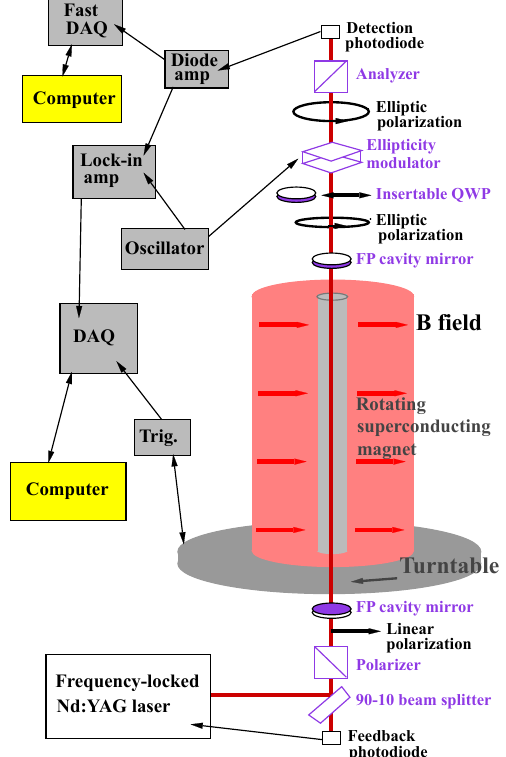
Figure 10. Schematic drawing of the PVLAS-LNL optical and acquisition setup.